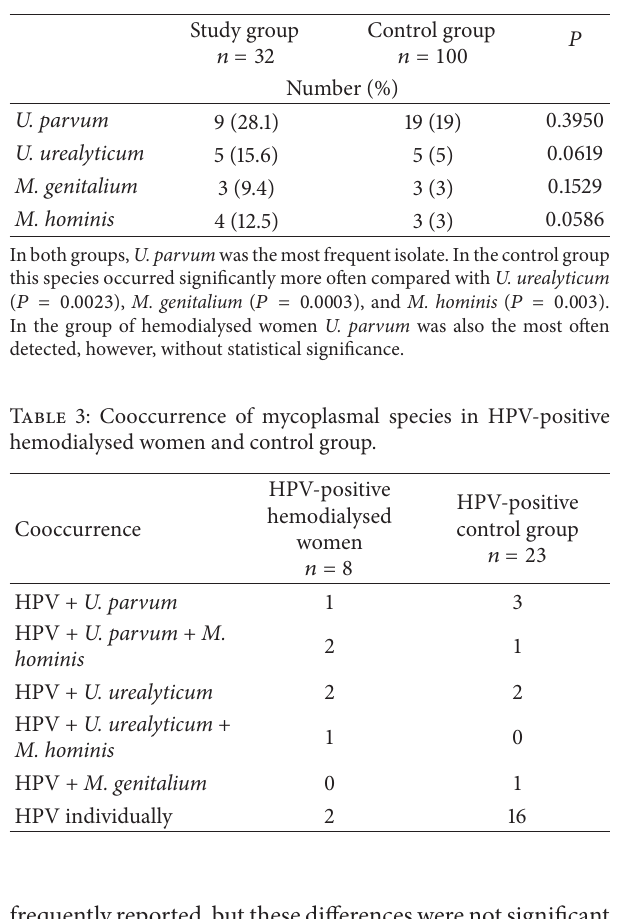
Table 2: Frequency of individual urogenital mycoplasmas in the group of hemodialysed women and in controls.